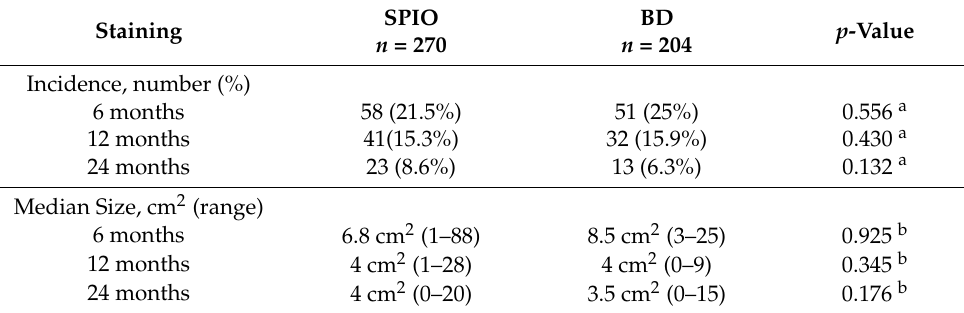
Table 2. Incidence and median size of postoperative skin staining in women treated with breast- conserving surgery and injected with superparamagnetic nanoparticles of iron oxide (SPIO) and Blue Dye (BD) for sentinel lymph node